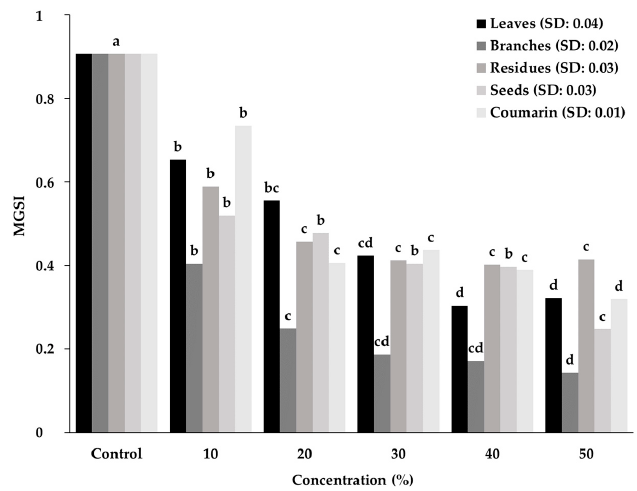
Figure 2. Mycelial Growth Speed Index (MGSI) of Colletotrichum musae subjected to different concentrations of Dipteryx punctata ethanol extracts and coumarin standard. SD = standard deviation. Means followed by the same lowercase letters in the columns do not differ from each other by Tukey’s test ( p ≤ 0.05). For each product used in the control of C. musae , first-degree functions (y = ax ± b) Table 1. Mean diameter of Colletotrichum musae colonies subjected to ethanolic extracts of Dipteryx punctata and to coumarin standard, at different